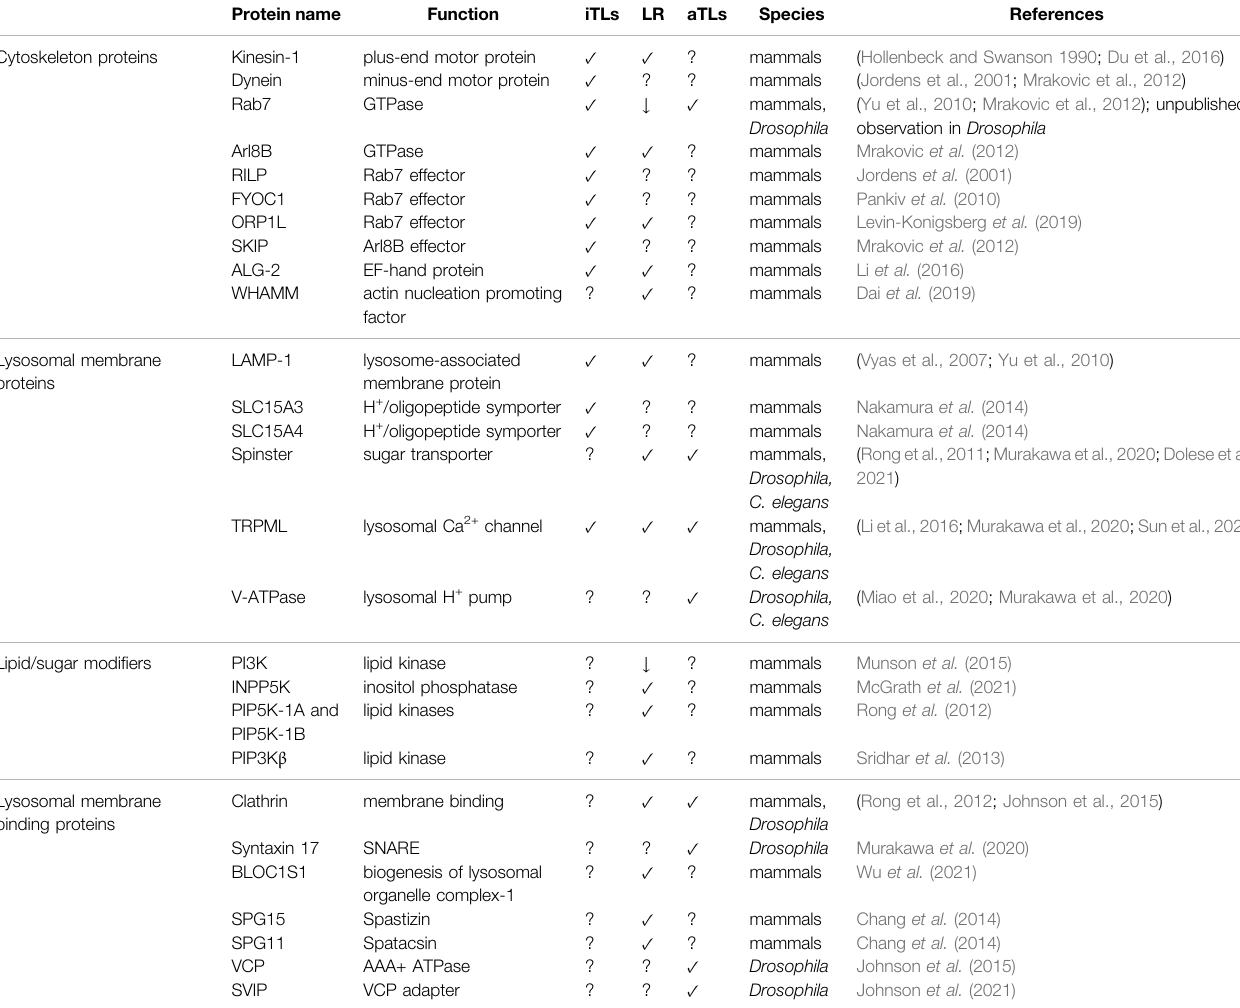
TABLE 1 | Proteins that associate with lysosomes and directly modulate TLs in immune cells (iTLs), lysosome reformation (LR), and/or autophagy